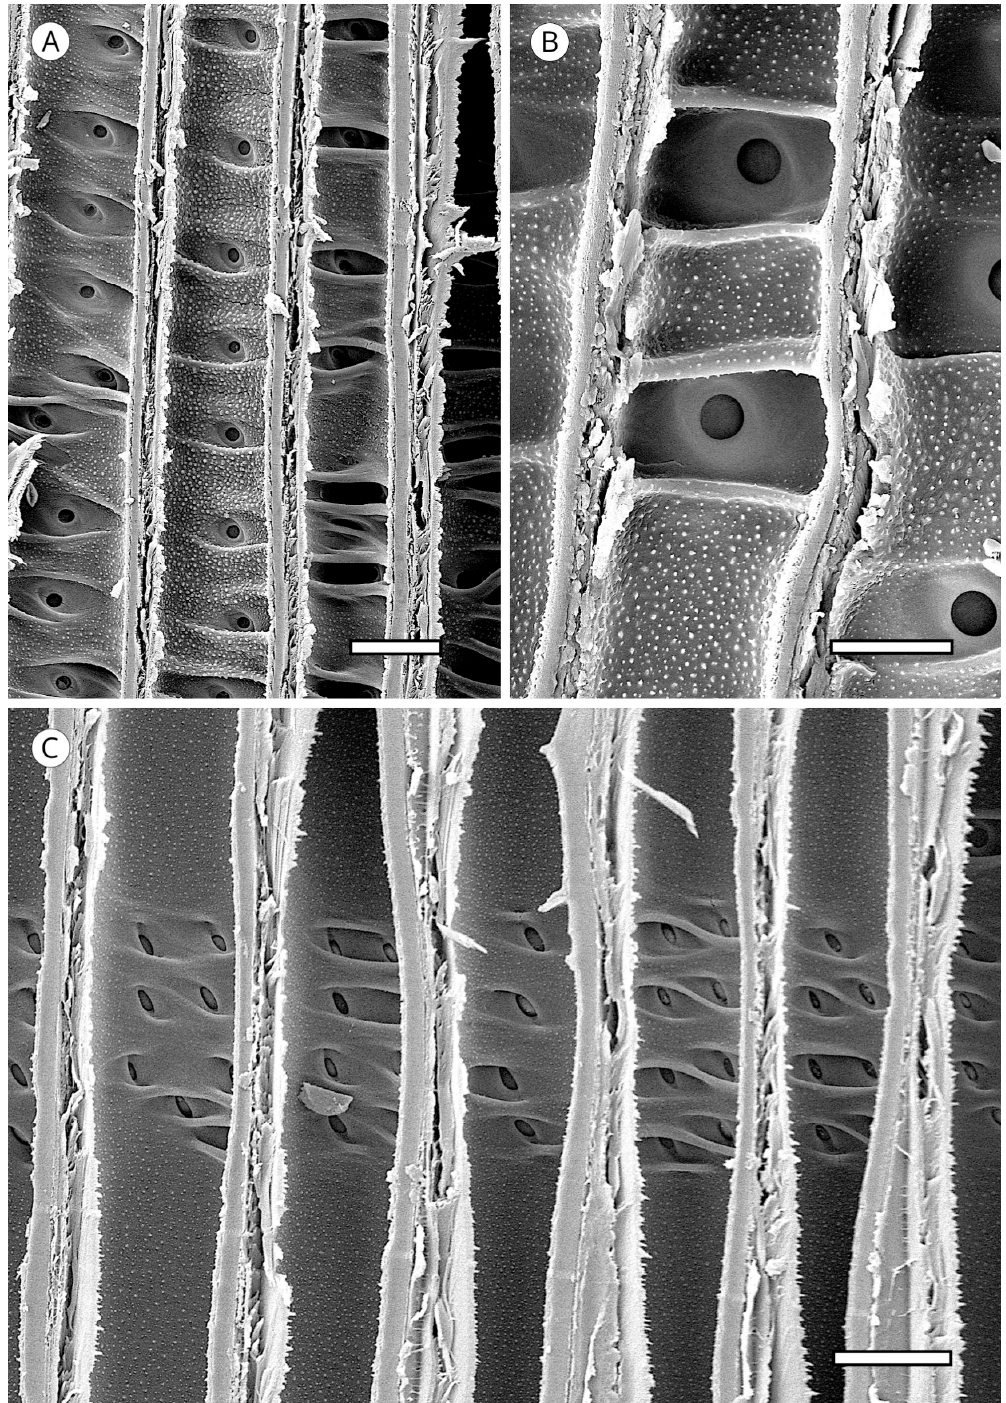
Figure 23. Callitroid thickenings (SEM). ( A ) In axial tracheids (radial section) in Callitris verrucosa (A.Cunn. ex Endl.) F.Muell.; ( B ) In axial tracheids (radial section) in Callitris endlicheri (Parl.) F.M.Bailey; ( C ) In cross-field pits (radial section) in Callitris verrucosa (A.Cunn. ex Endl.) F.Muell. Scale bars. ( A , C ) = 25 μ m; ( B ) = 10 μ m.